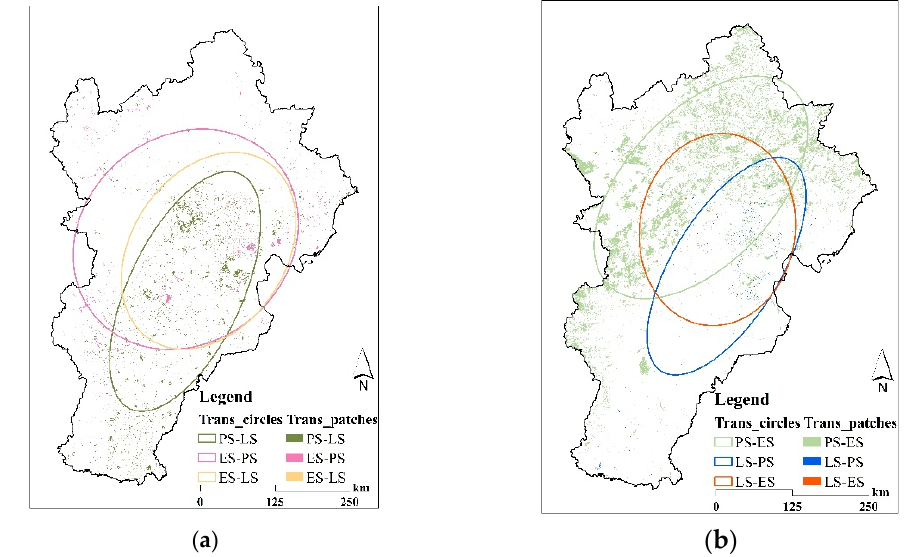
Figure 9. Distribution and standard deviational ellipse of PLES transfer. ( a ) Decreasing nature type; ( b ) increasing nature type.